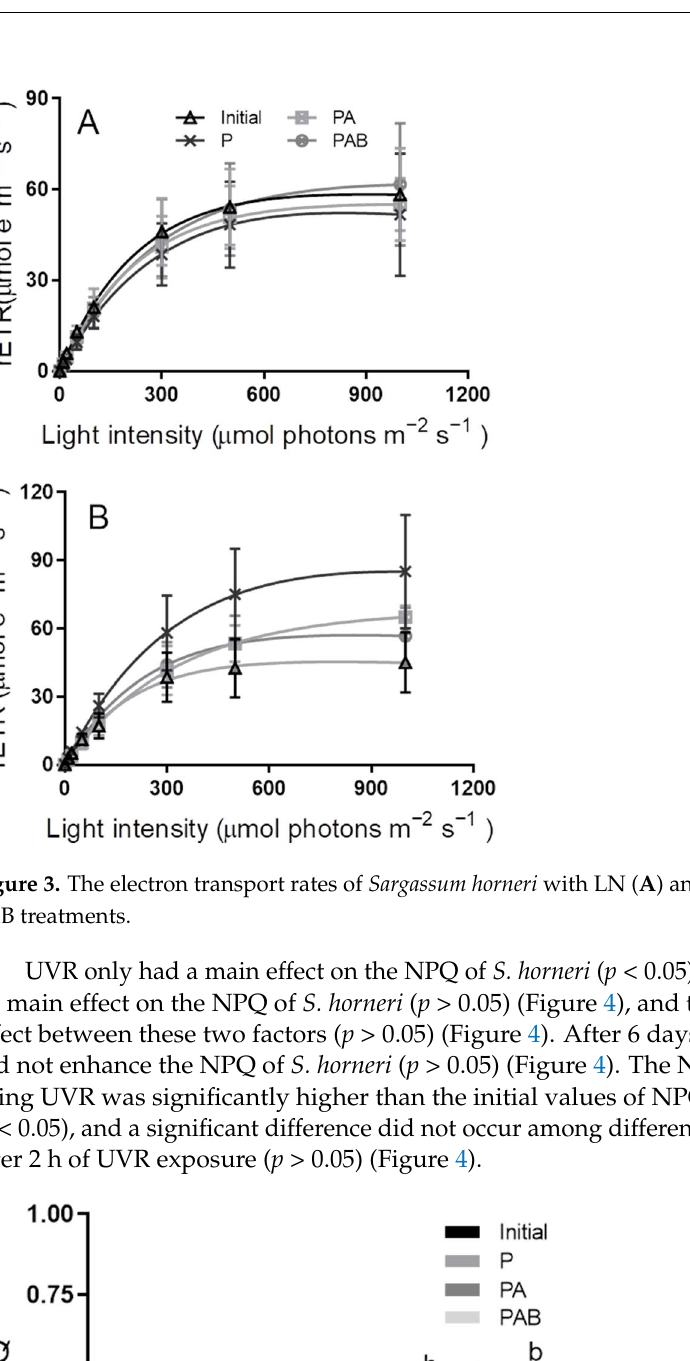
Figure 3. The electron transport rates of Sargassum horneri with LN ( A ) and HN ( B ) under P, PA, and PAB treatments. Significant differences among all treatments are indicated by different low- ercase letters ( p < 0.05).